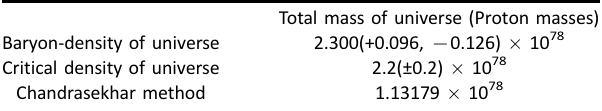
Table 2 . Total mass of universe [26].